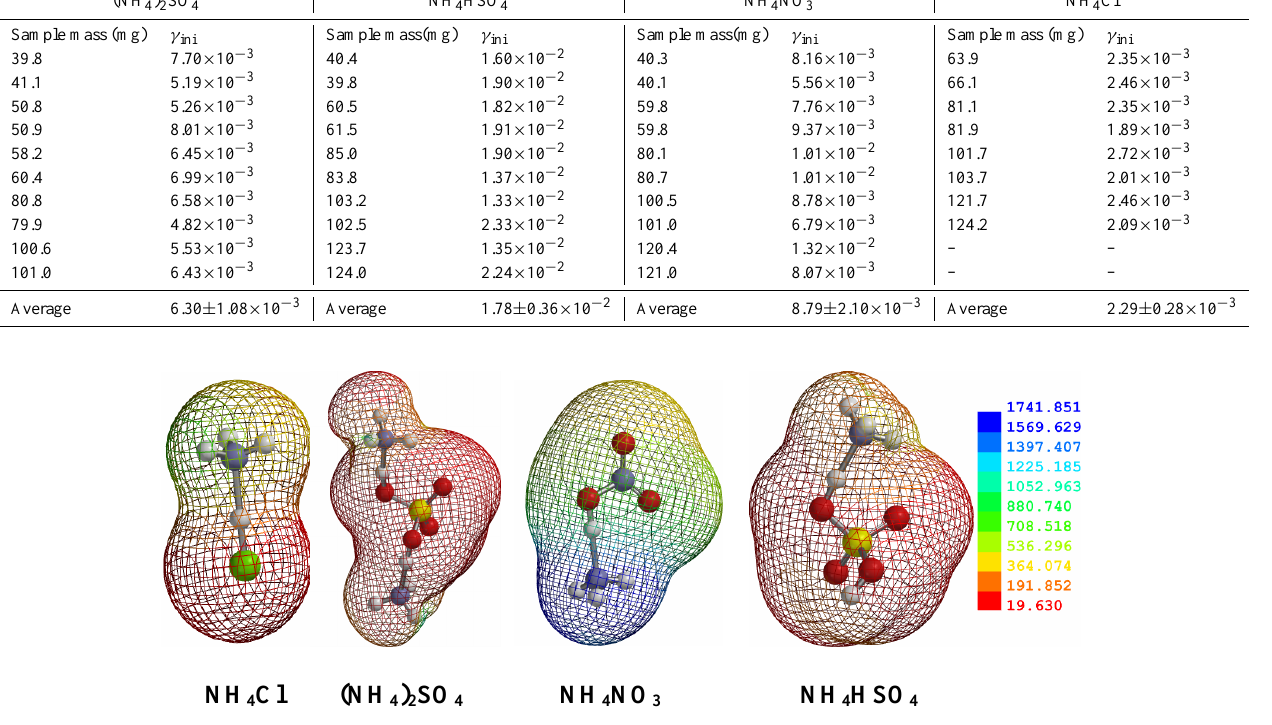
Fig. 5. Electrostatic potential maps for ammonium salts.